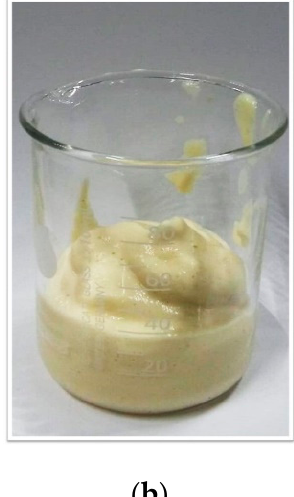
Figure 4: Visual aspect of samples E2.3.1.20 ( a ) and E2.3.3.20 ( b ).